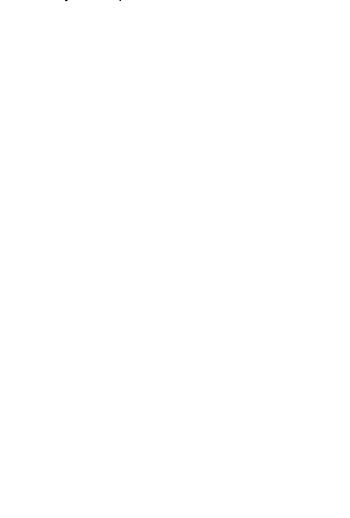
NEI VFQ-25: National Eye Institute Visual Function Questionnaire-25. GH: General Health, GV: General Vision, OP: Ocular Pain, NA: Near Activities, DA: Distance Activities, VSSF: Vision Speci fi c Social Functioning, VSMH: Vision Speci fi c Mental Health, VSRD: Vision Speci fi c Role Dif fi culties, VSD: Vision Speci fi c Dependency, D: Driving, CV: Color Vision, PV: Peripheral Vision, OCS: Overall Composite Score, VA: visual acuity. AMD: age-related